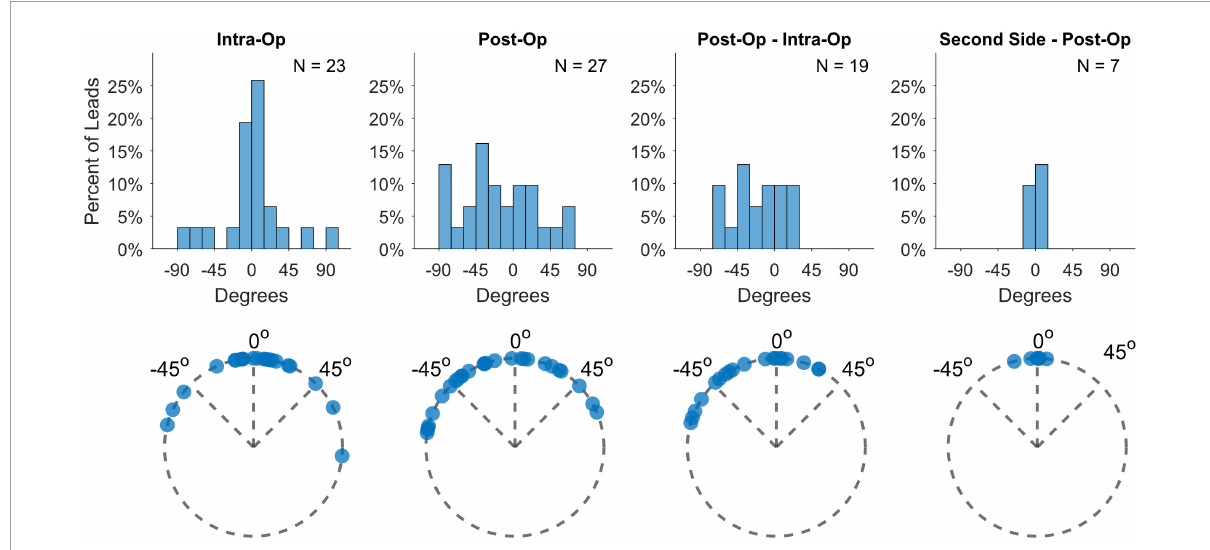
FIGURE1 Lead orientation estimates during lead placement (intra-op) and immediately after surgery (post-op), as well as their differences and the differences from post-op to estimates derived from second-side surgery more than a year later.